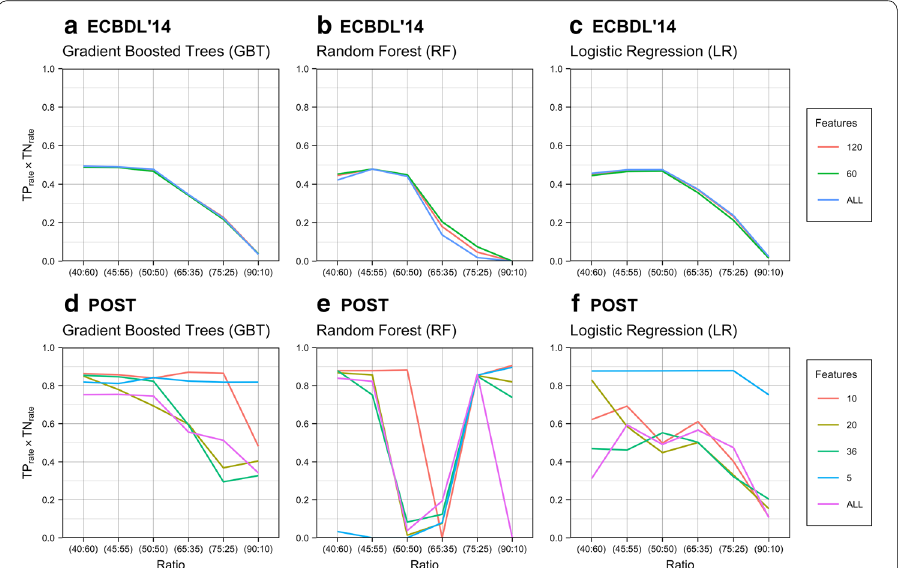
Fig. 2 (Distributions and Feature Selection scores): Average scores are shown on this figure for each dataset, sampling ratio distribution, and learner. In addition, the figure shows the number of selected features used to train the three models for each case study. a – c depict the ECBDL’14 case study and d – f depict the POST